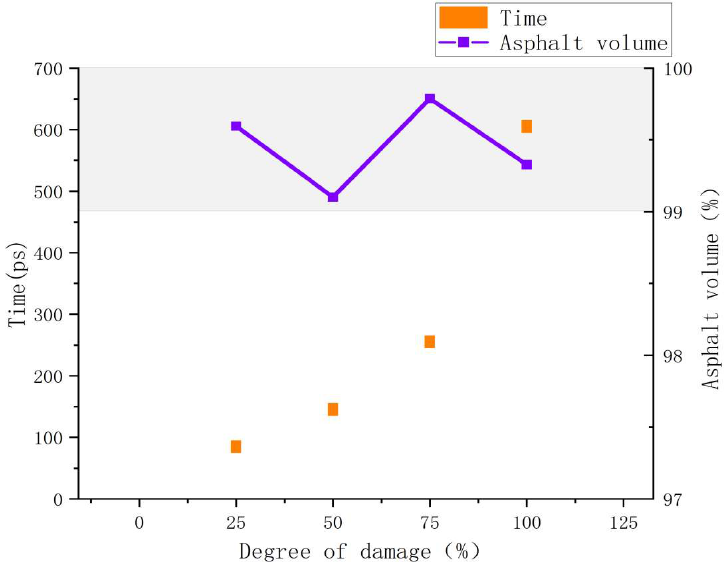
Figure 17. Different damage degree inflection point time and asphalt volume